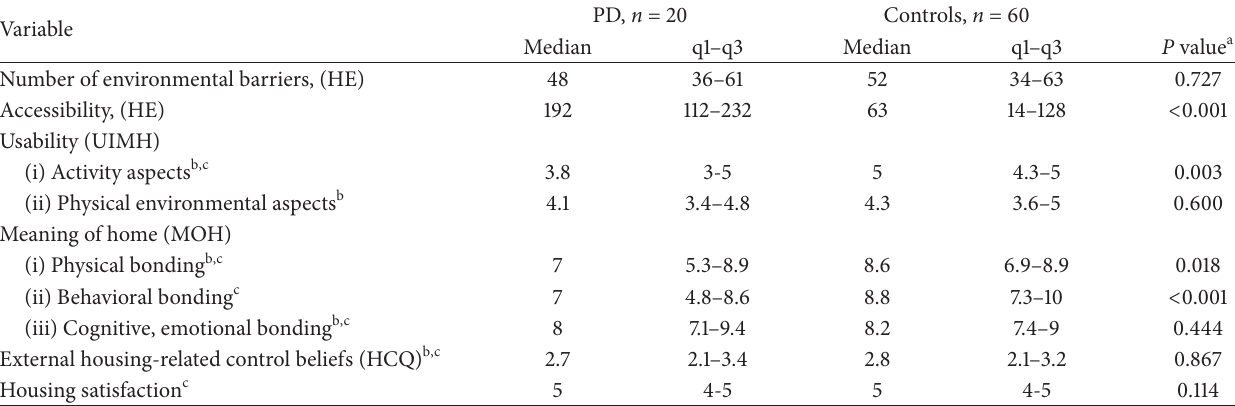
Table 2: Comparison of aspects of housing between very old people reporting having Parkinson’s disease (PD) ( n = 20) and controls not reporting having PD ( n = 60).